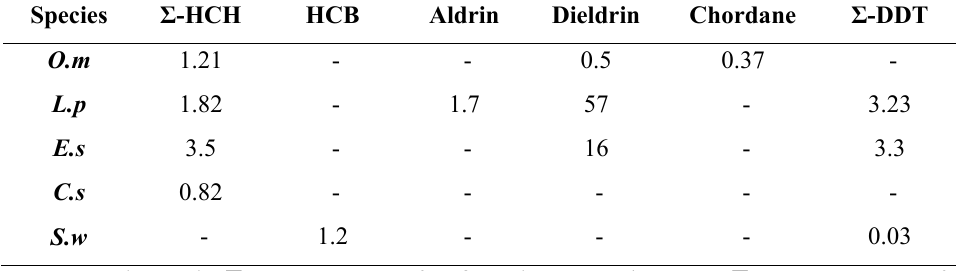
Table 1. Concentration of OCPs (ng/g wet wt.) in the fish samples from Veeranam Lake. Species Σ-HCH HCB Aldrin Dieldrin Chordane Σ-DDT